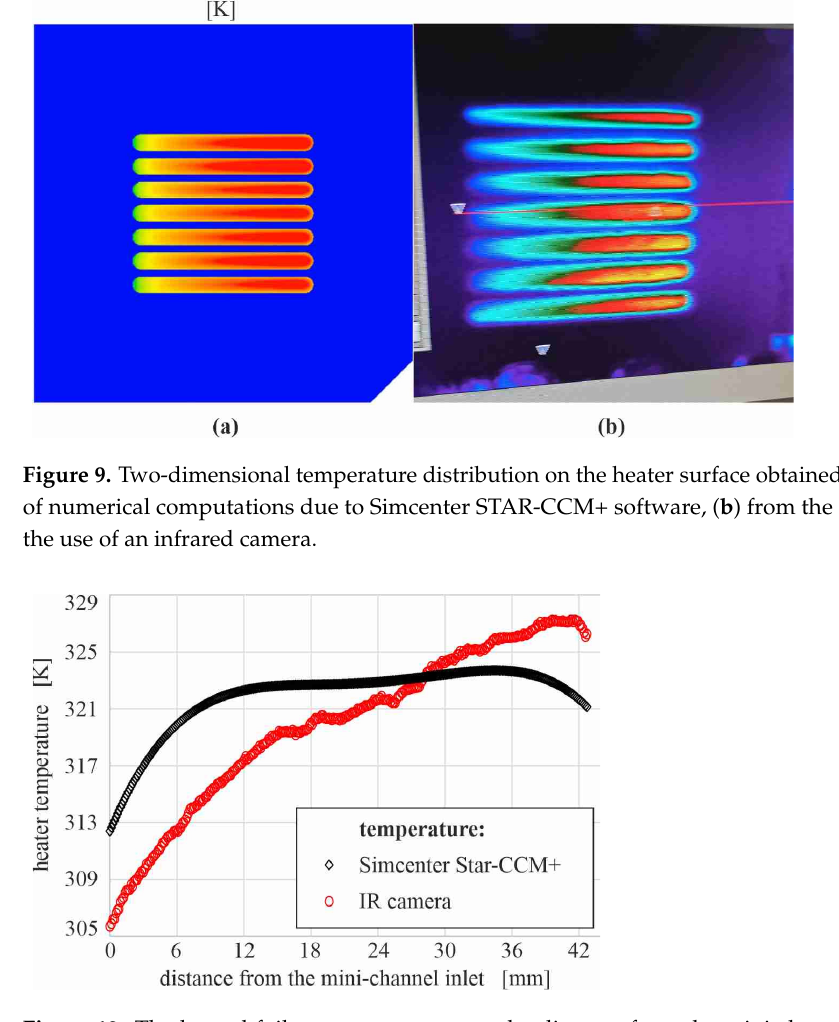
Figure 10. The heated foil temperature versus the distance from the mini ‐ channel inlet obtained from the experimental measurement (using an infrared camera) and from numerical computations (according to Simcenter STAR ‐ CCM+ software).